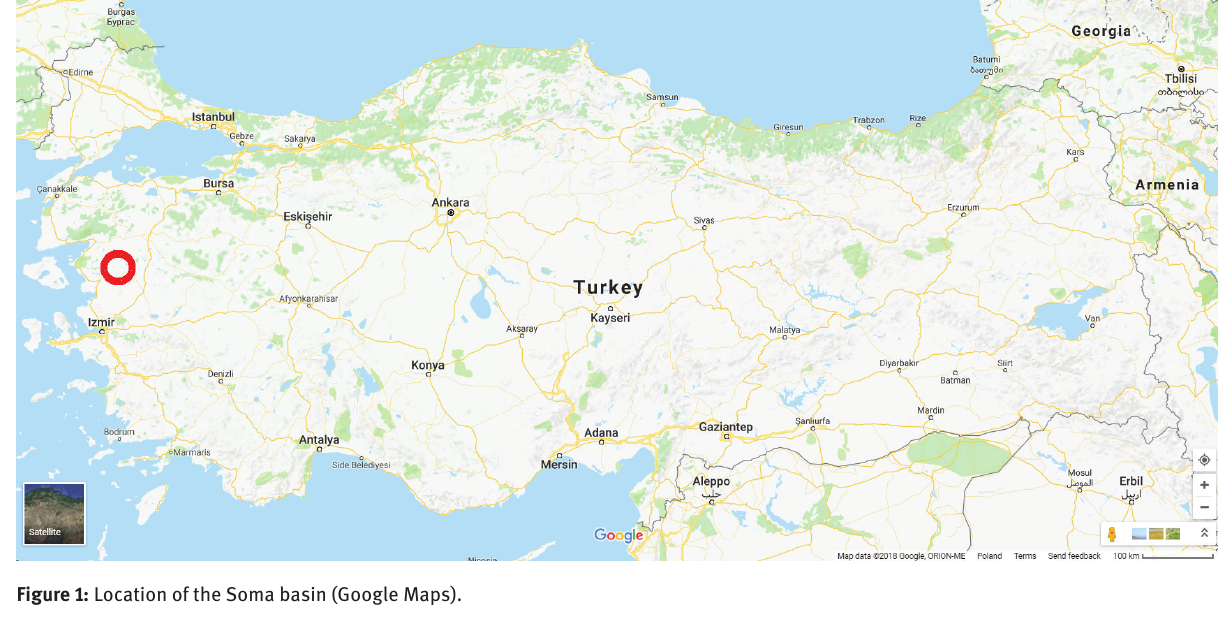
Figure 1: Location of the Soma basin (Google Maps).